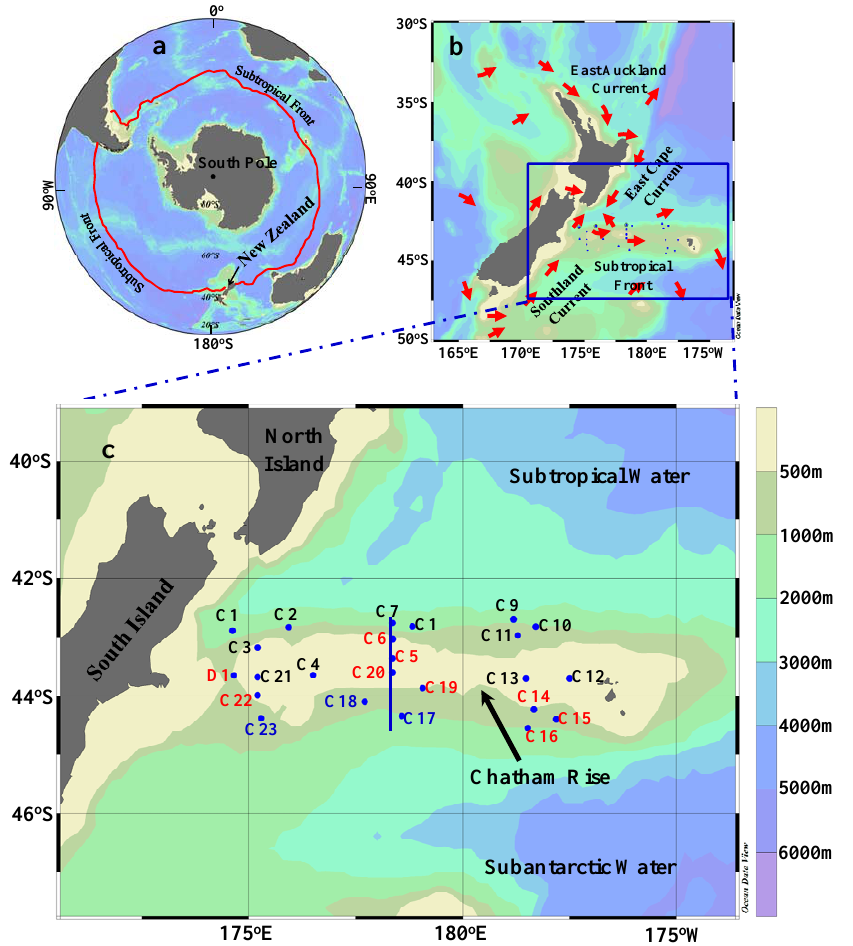
Fig. 1. Hemispherical map of the Southern Ocean showing the approximate location of the Subtropical Front as a red line (a) , with the map of the study area showing the mean circulation and surface water masses (Nodder, 1997) (b) ; the location of sampling sites during the May-June 2008 research cruise TAN0806 (c) ; and the stations with salinities > 34.8 (high), 34.5–34.8 (mid), and < 34.5 (low) marked in black, red, and blue, respectively. The blue line represents the transect where stations were sampled throughout the water column (Transect M). The bathymetry of the study area is also shown to emphasize the location of the Chatham